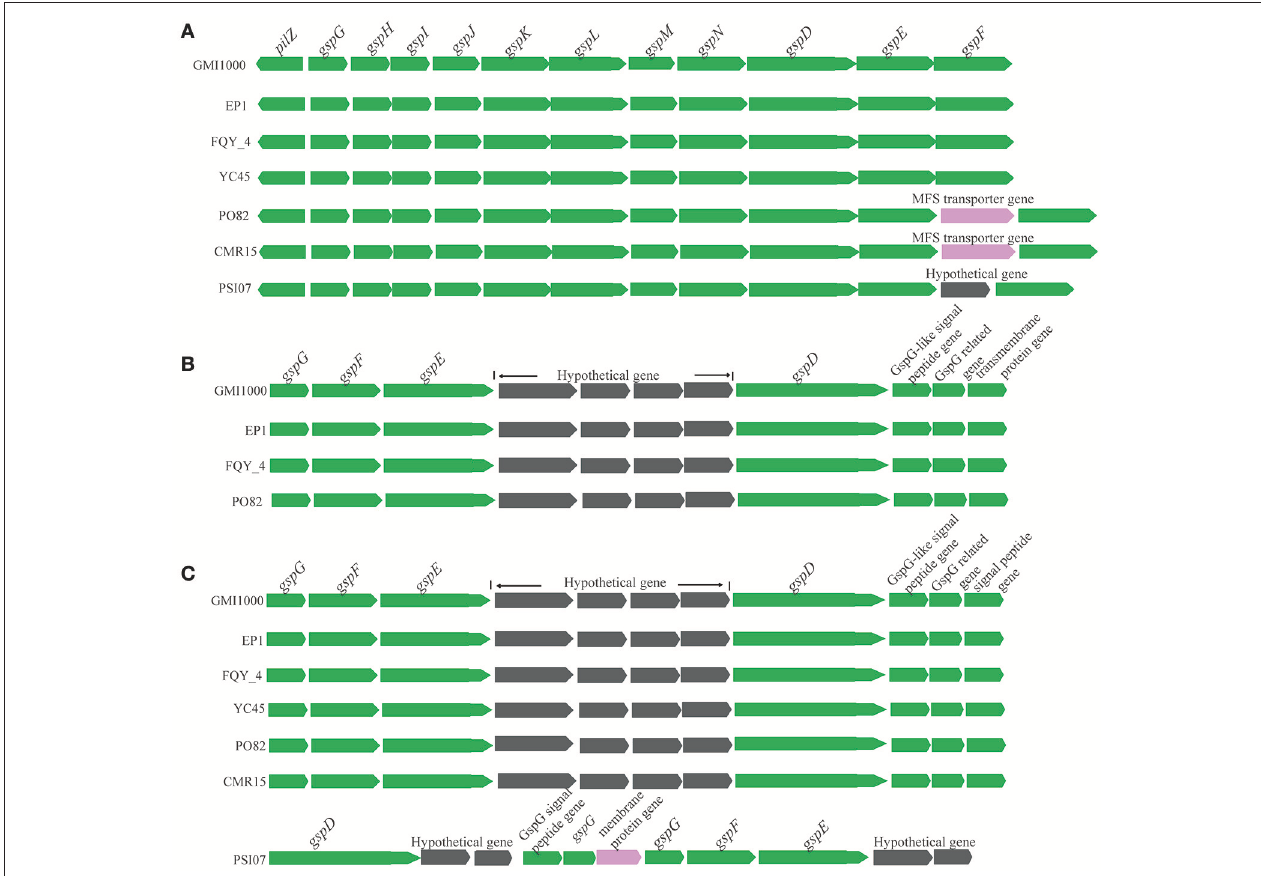
FIGURE 7 | Genetic organization of T2SS gene clusters in R. solanacearum species. (A) The orthodox system encoded by 12 genes in the chromosome (from 375,919 to 388,223); (B) (from 1,297,715 to 1,307,671), and (C) (from 4,212,126 to 4,221,456) are two unorthodox T2SS.